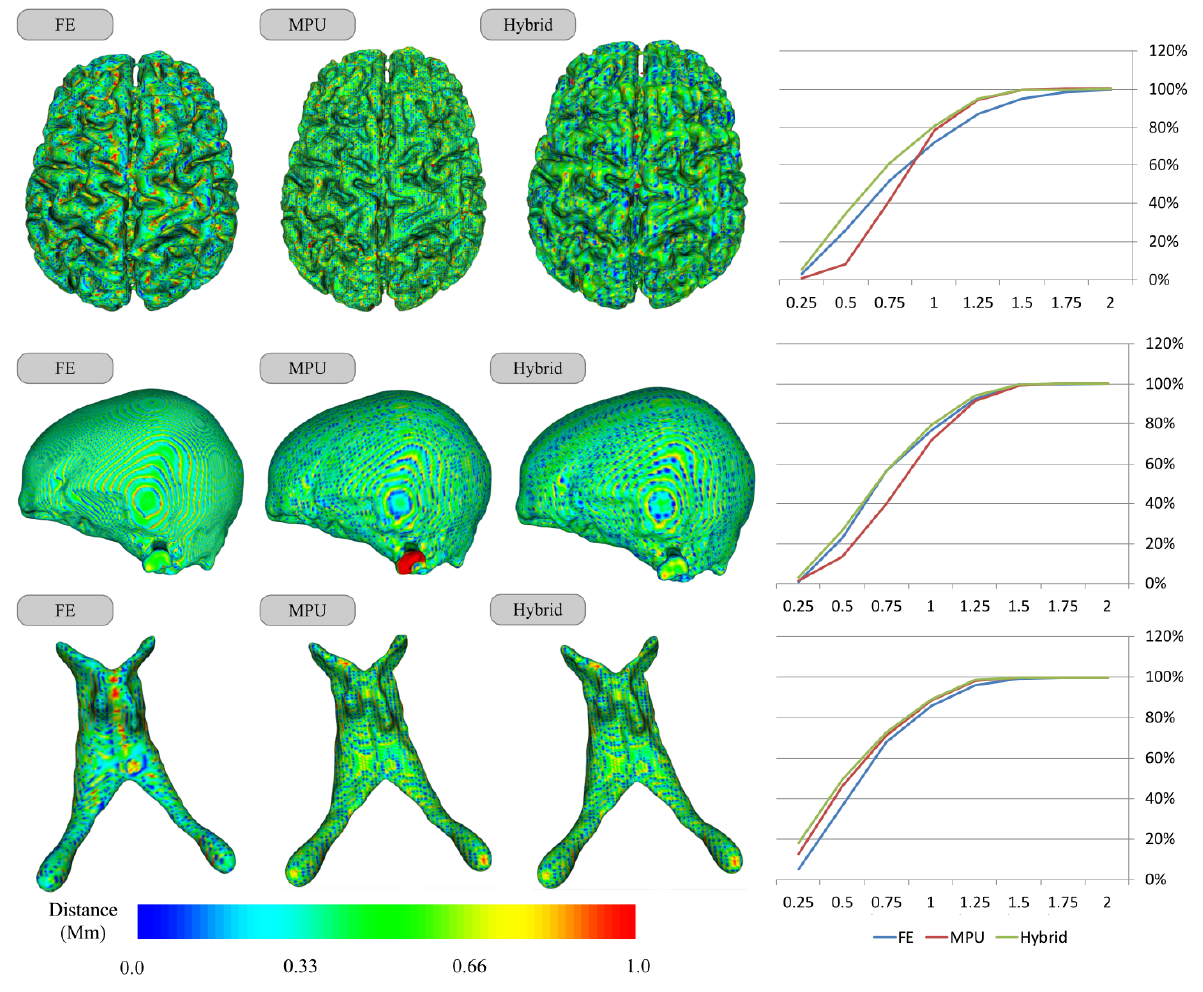
Figure 6. Distance from the segmentation for the reconstruction methods: FE, MPU, and Hybrid. The voxel size of the segmentation grid in XY dimension is of 1 mm; ( left ) reconstruction error using Hausdorff metric; ( right ) cumulative percentage of surface points as a function of their distance to the segmentation. Table 2. Approximation quality corresponding to each of the four reconstructed models (Brain, Ventricle, Skull-Bone, and Kidney). Metrics are calculated in units of voxels